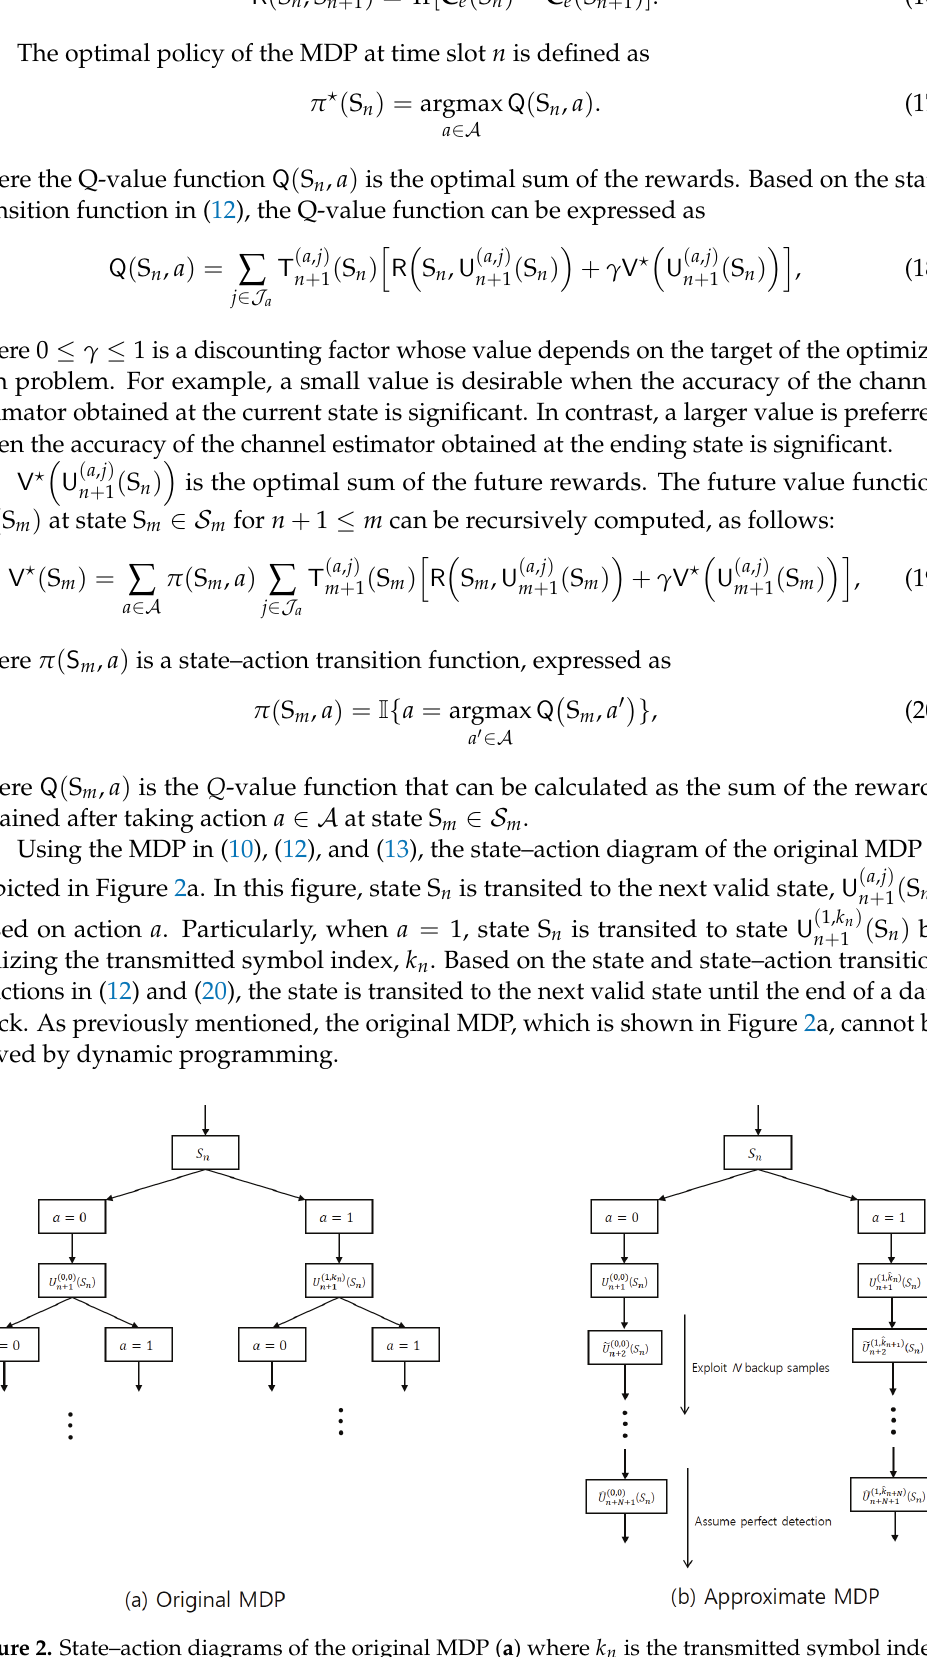
Figure 2. State–action diagrams of the original MDP ( a ) where k n is the transmitted symbol index, and the approximate MDP ( b ) where ˆ k n is the detected symbol index for a ∈ A and S n ∈ S n